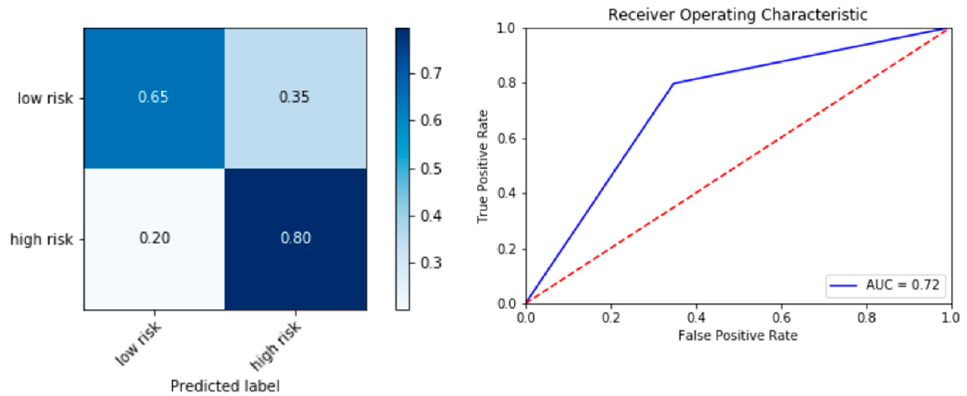
Figure 5. Elimination of Id3 SNP as input variable reduces model performance. Performance of the model drops when Id3 SNP was removed. Positive predictive value (PPV) of predicting high risk group drops from 87% to 80% and NPV of predicting low risk group drops from 81% to 65%. AUC of ROC also drops from 0.84 to 0.72.